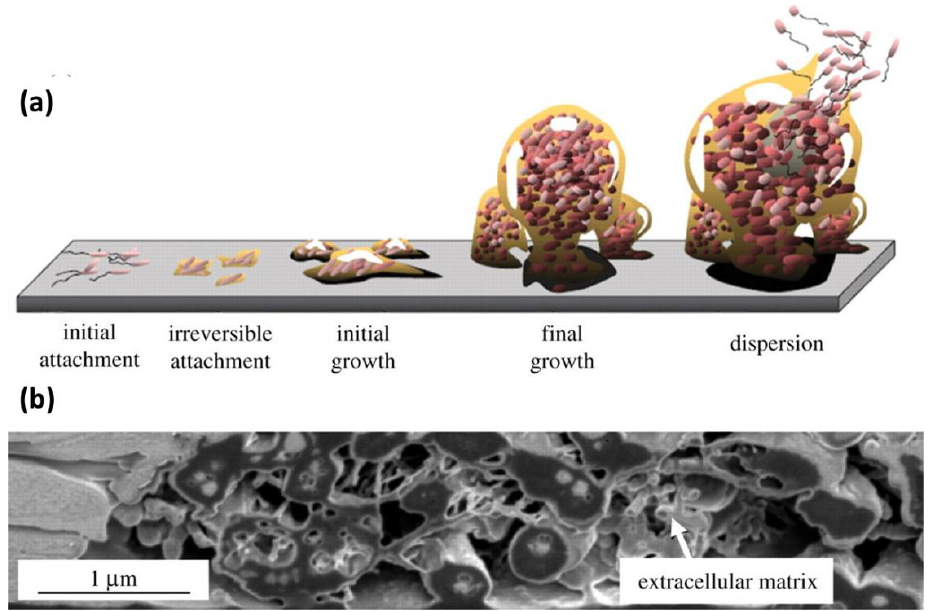
Figure 18. Biofilm development process. ( a ) Five-stage colonization process and ( b ) SEM of biofilm cross section highlighting the bacterial extracellular matrix morphology. Reproduced with permission from ref. [106].